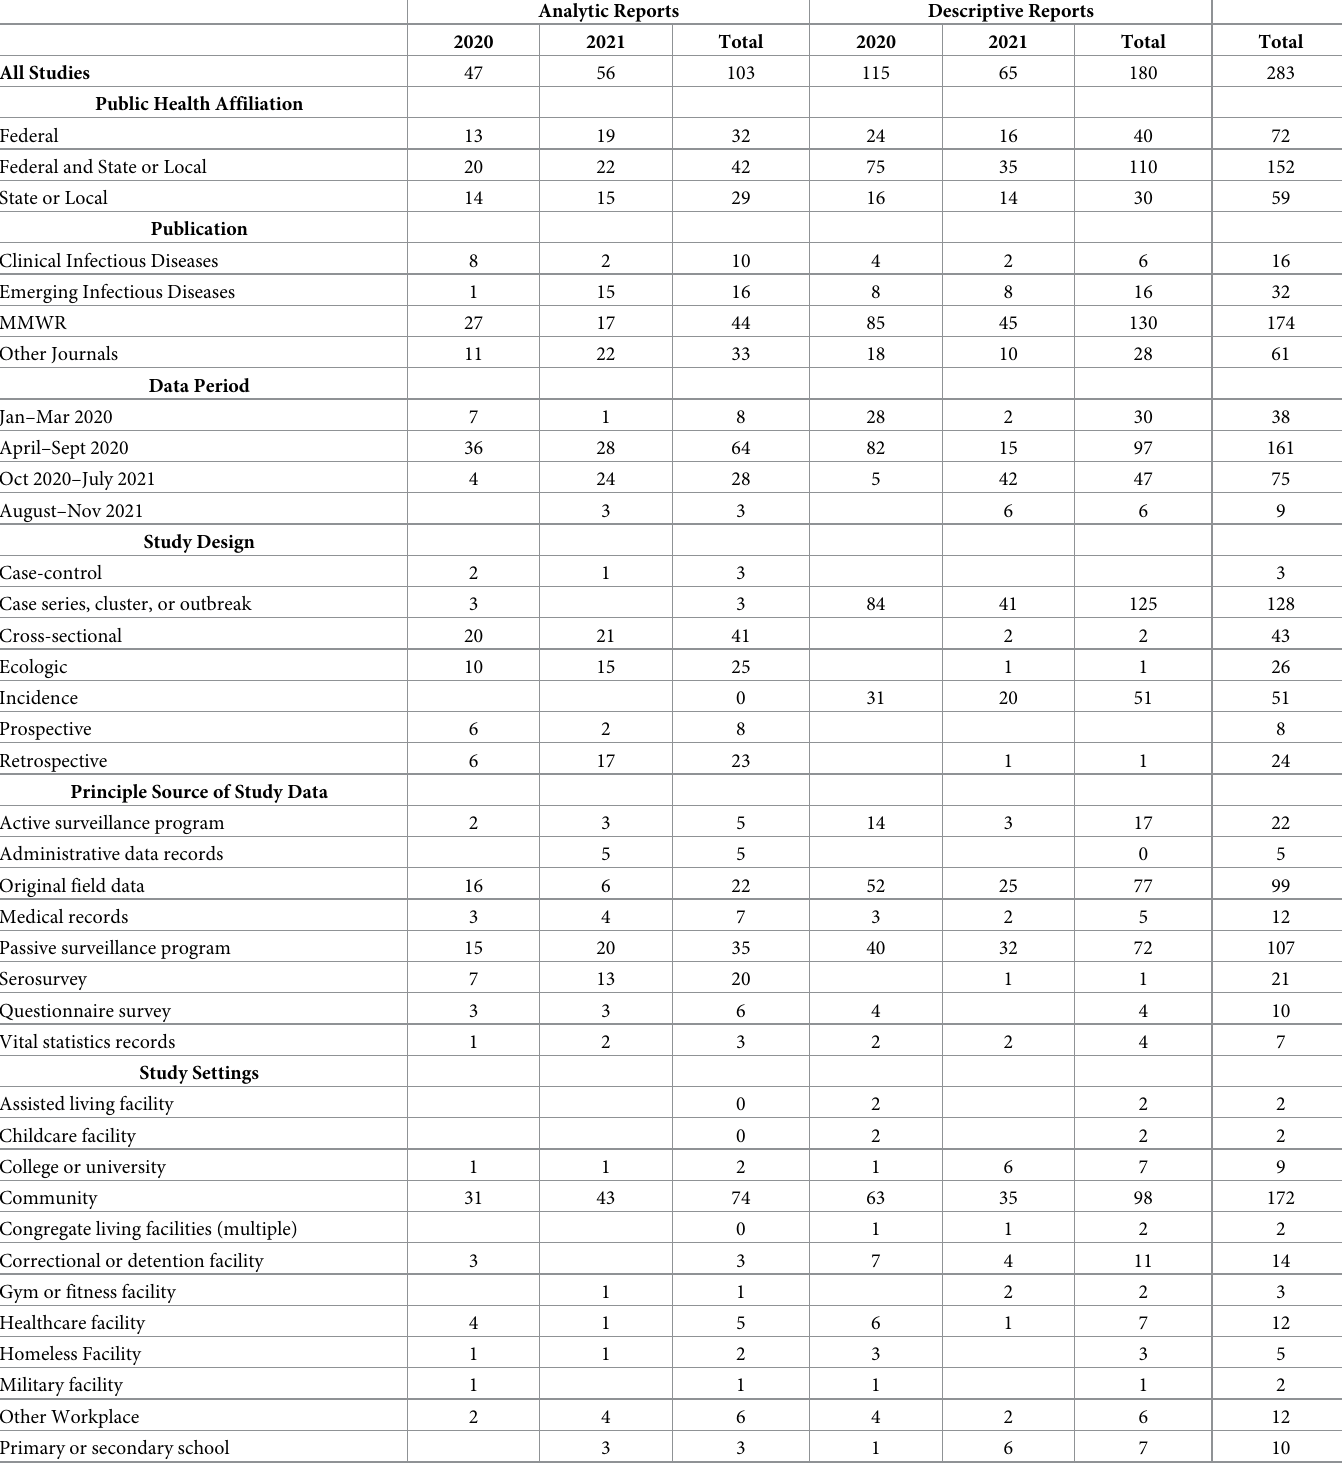
Table 4. Epidemiologic studies on COVID-19 transmission, infection severity, disease burden with US governmental public health authors affiliations published through November